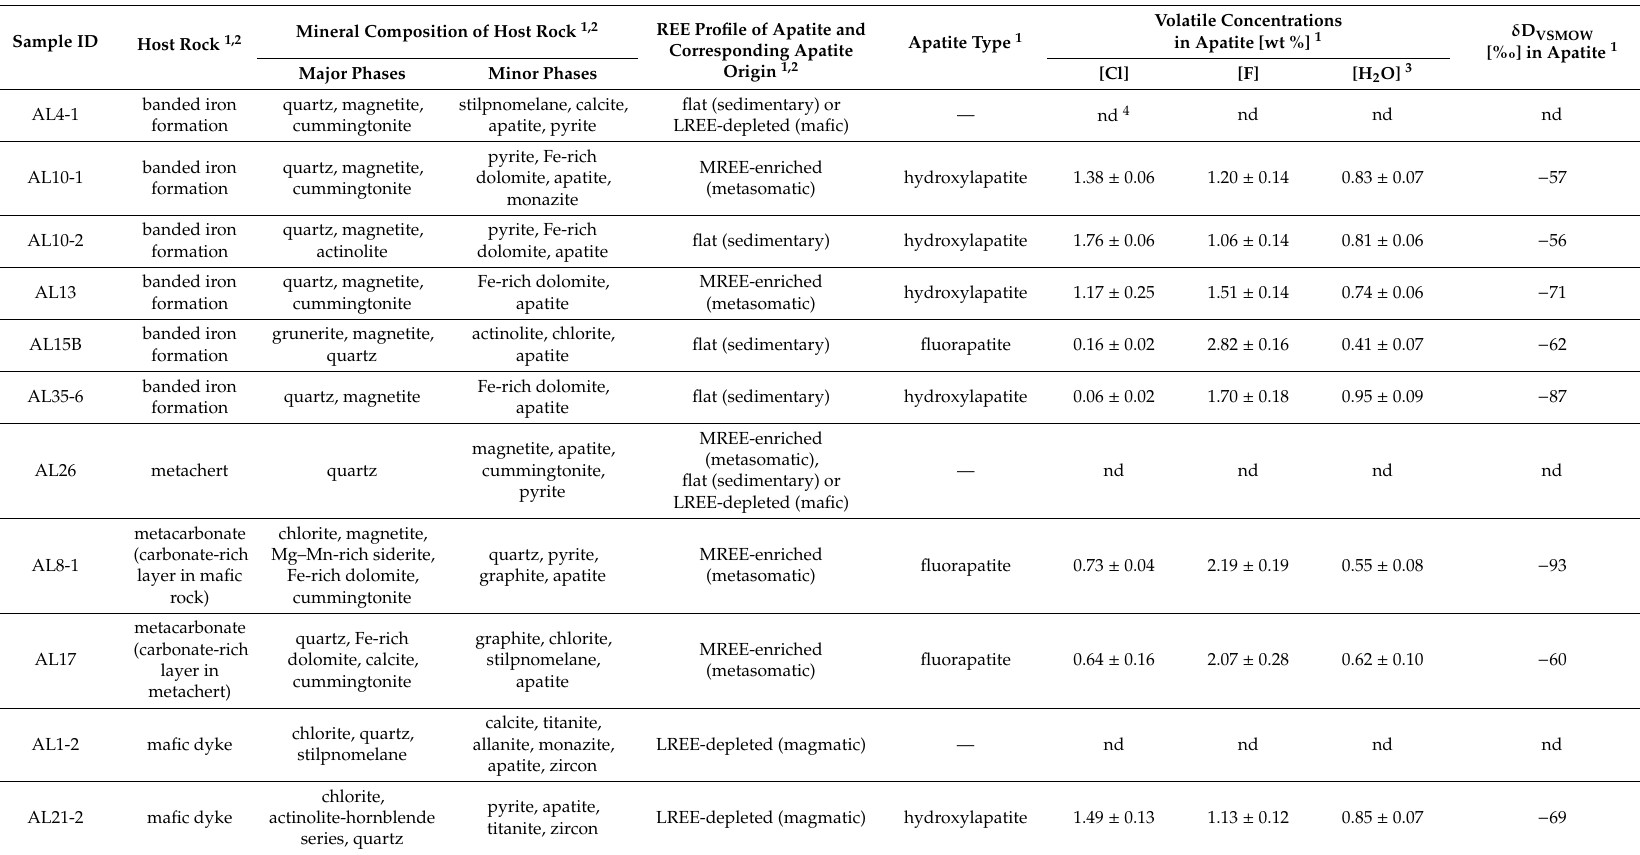
Table 1. List of samples used in this study, which were previously characterized for their chemical compositions and possible origin. Sample